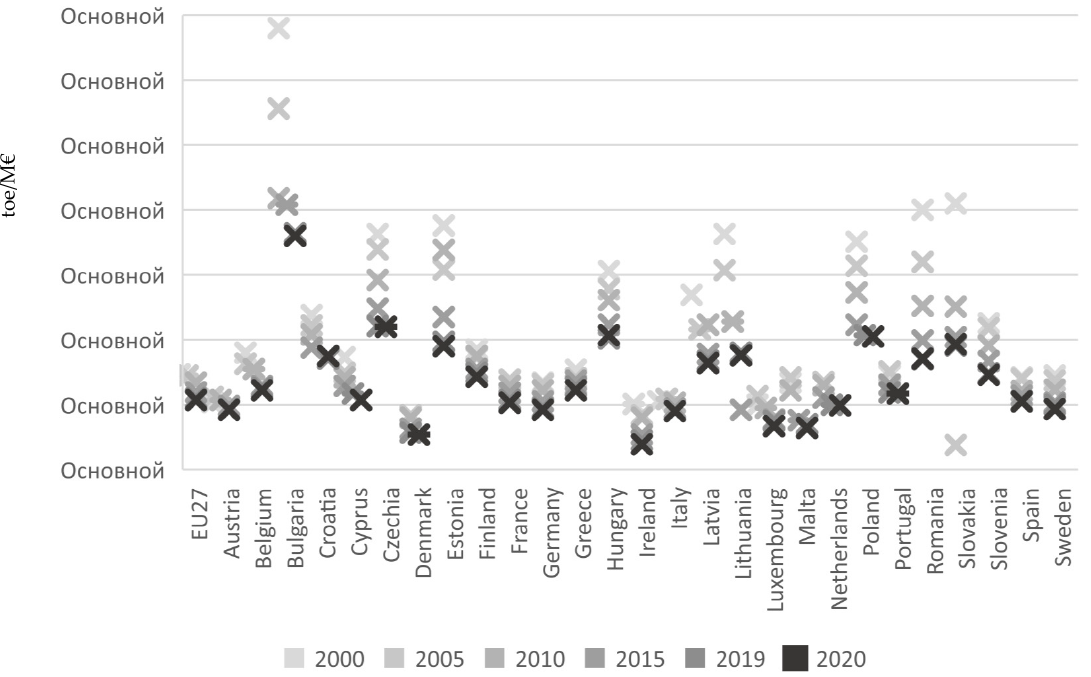
Figure 3. The energy intensity of the EU countries in 2000–2020, toe/M€. Source: compiled by the authors.